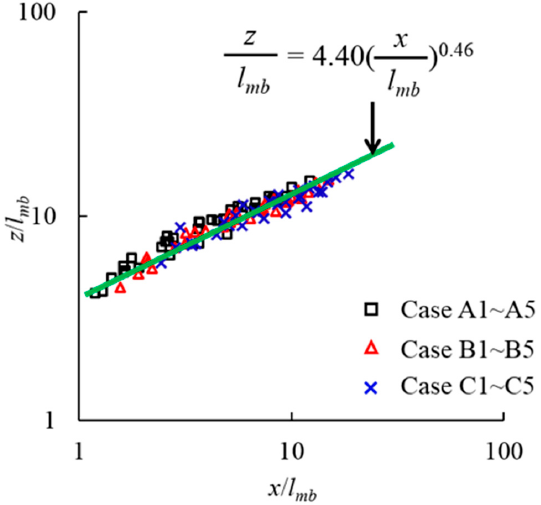
Figure 12. Equation for the trajectory of twin buoyant jets in the wave and current environment.